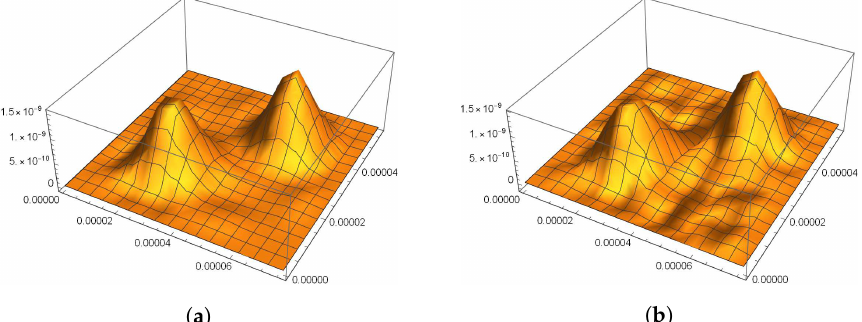
Figure 8. Comparison of the results when we vary the position of the observation set ˜ Ω . ( a ) Attainable target load with two peaks. ( b ) Recovered load.